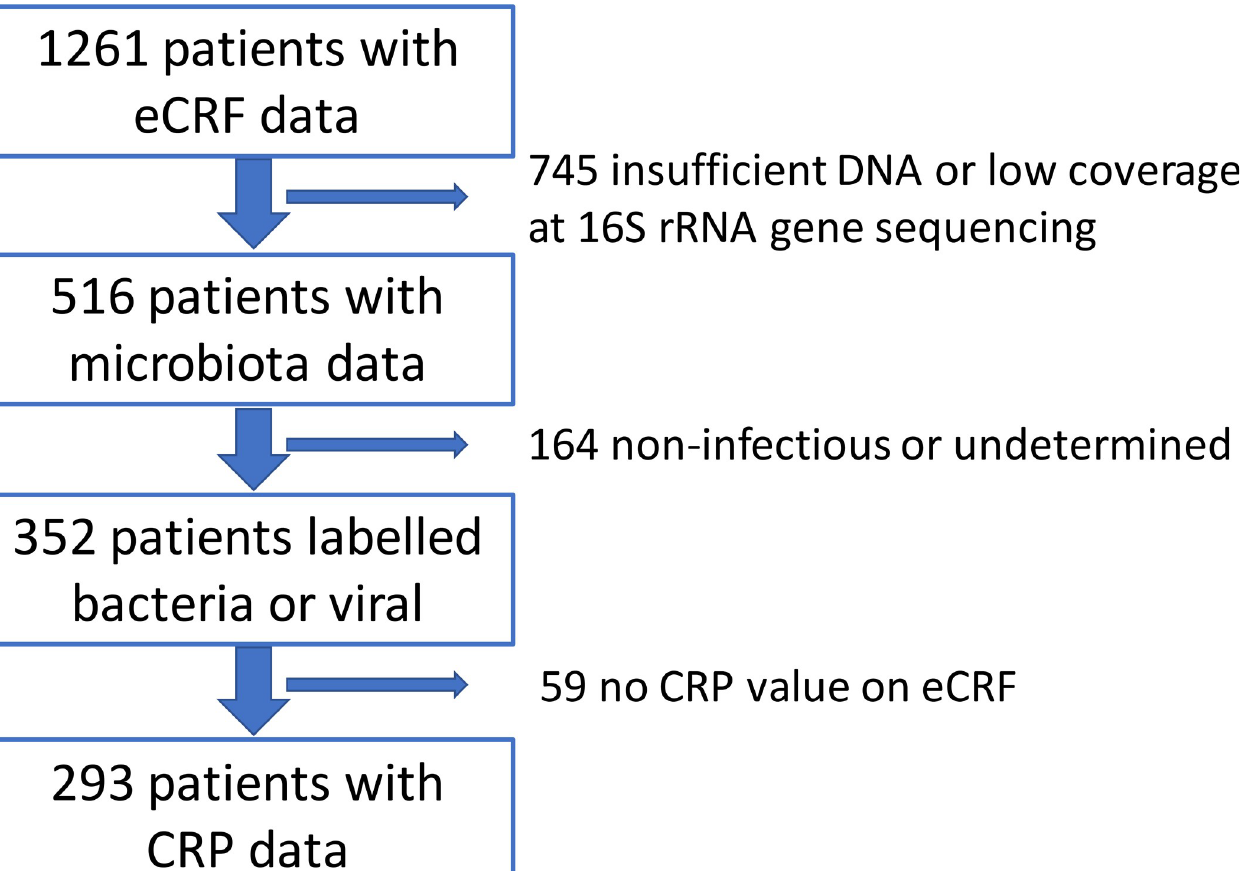
Fig 1. Patient filtering. LRTI patients from TAILORED-Treatment study underwent several filtering steps before they entered the classifier development stage. The eCRF data utilized in this publication was obtained from the following patient cohort [21]. eCRF: electronic Case Report Forms. CRP: C-reactive